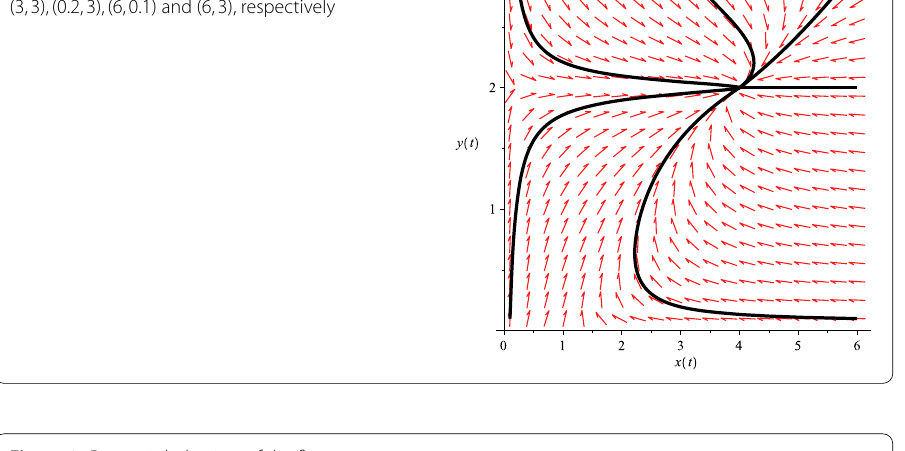
Figure 2 Dynamic behaviors of the first component of system (4.1) with the initial condition ( x (0), y (0)) =